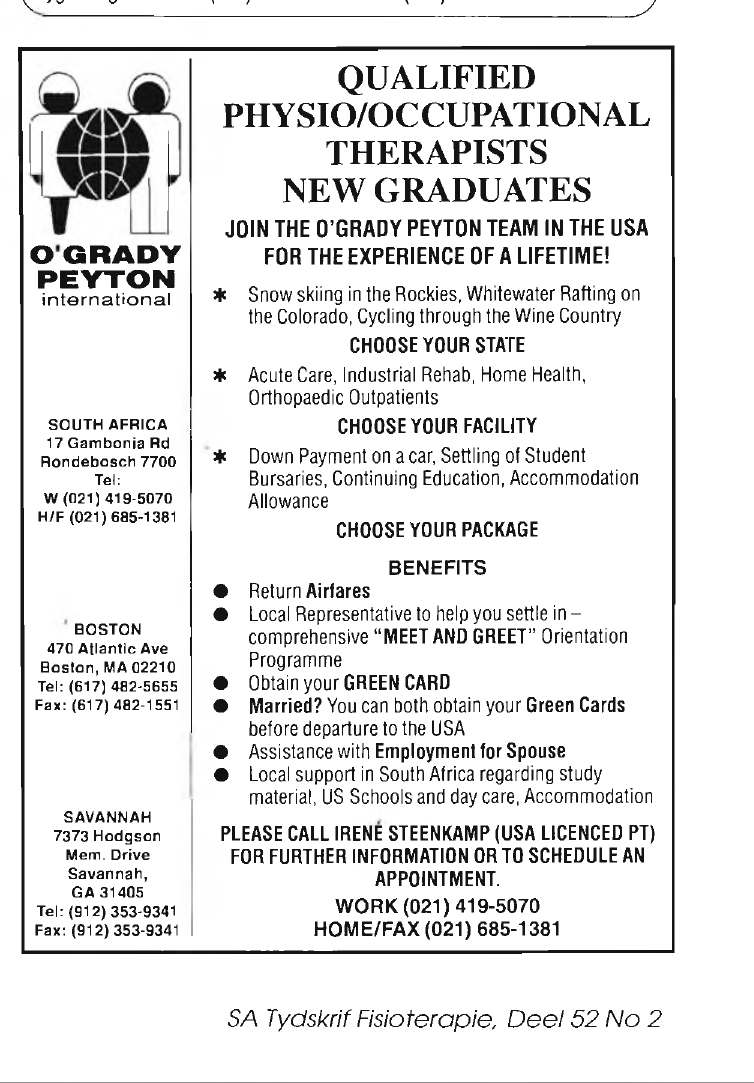
Figure 5: Reading -